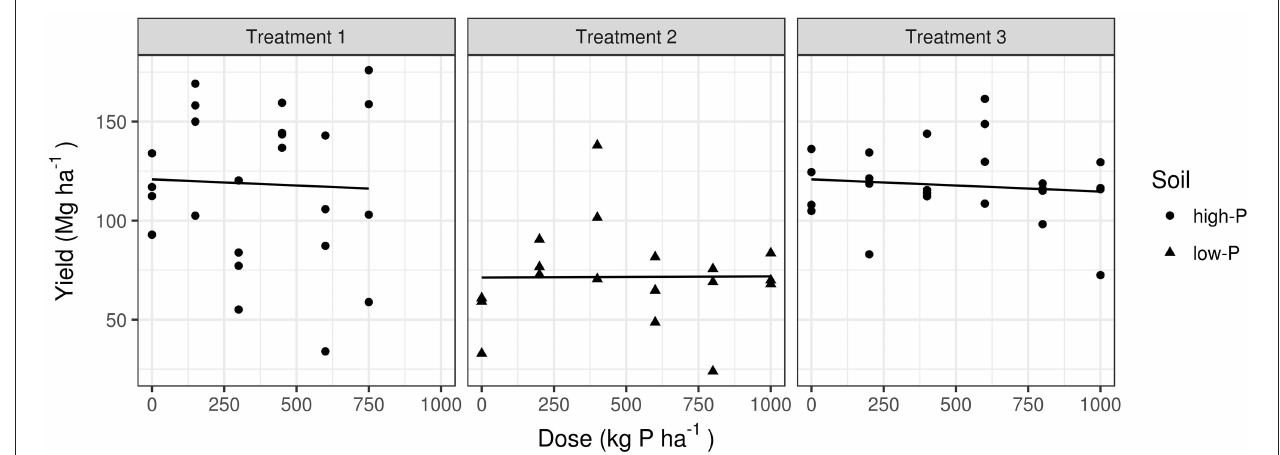
FIGURE 1 | Linear mixed models showing yield responses to P dosage in low-P and high-P soils.